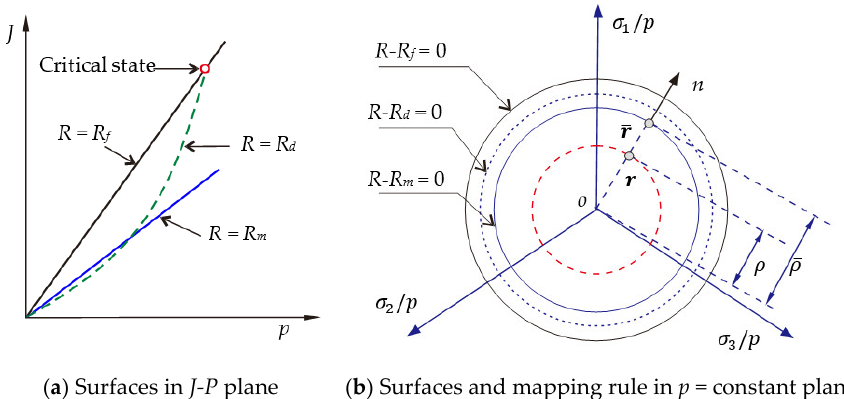
Figure 3. Bounding surfaces and mapping rule.